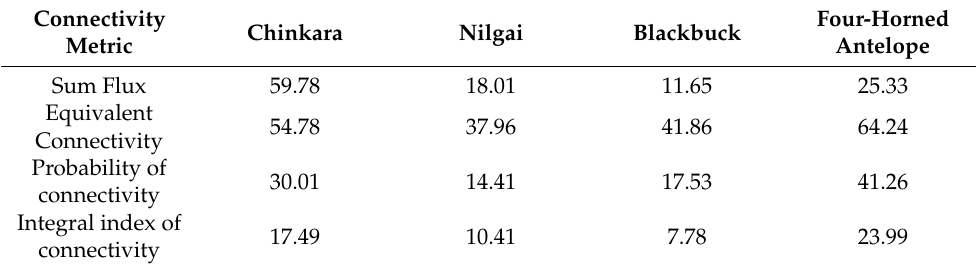
Four-Horned Antelope